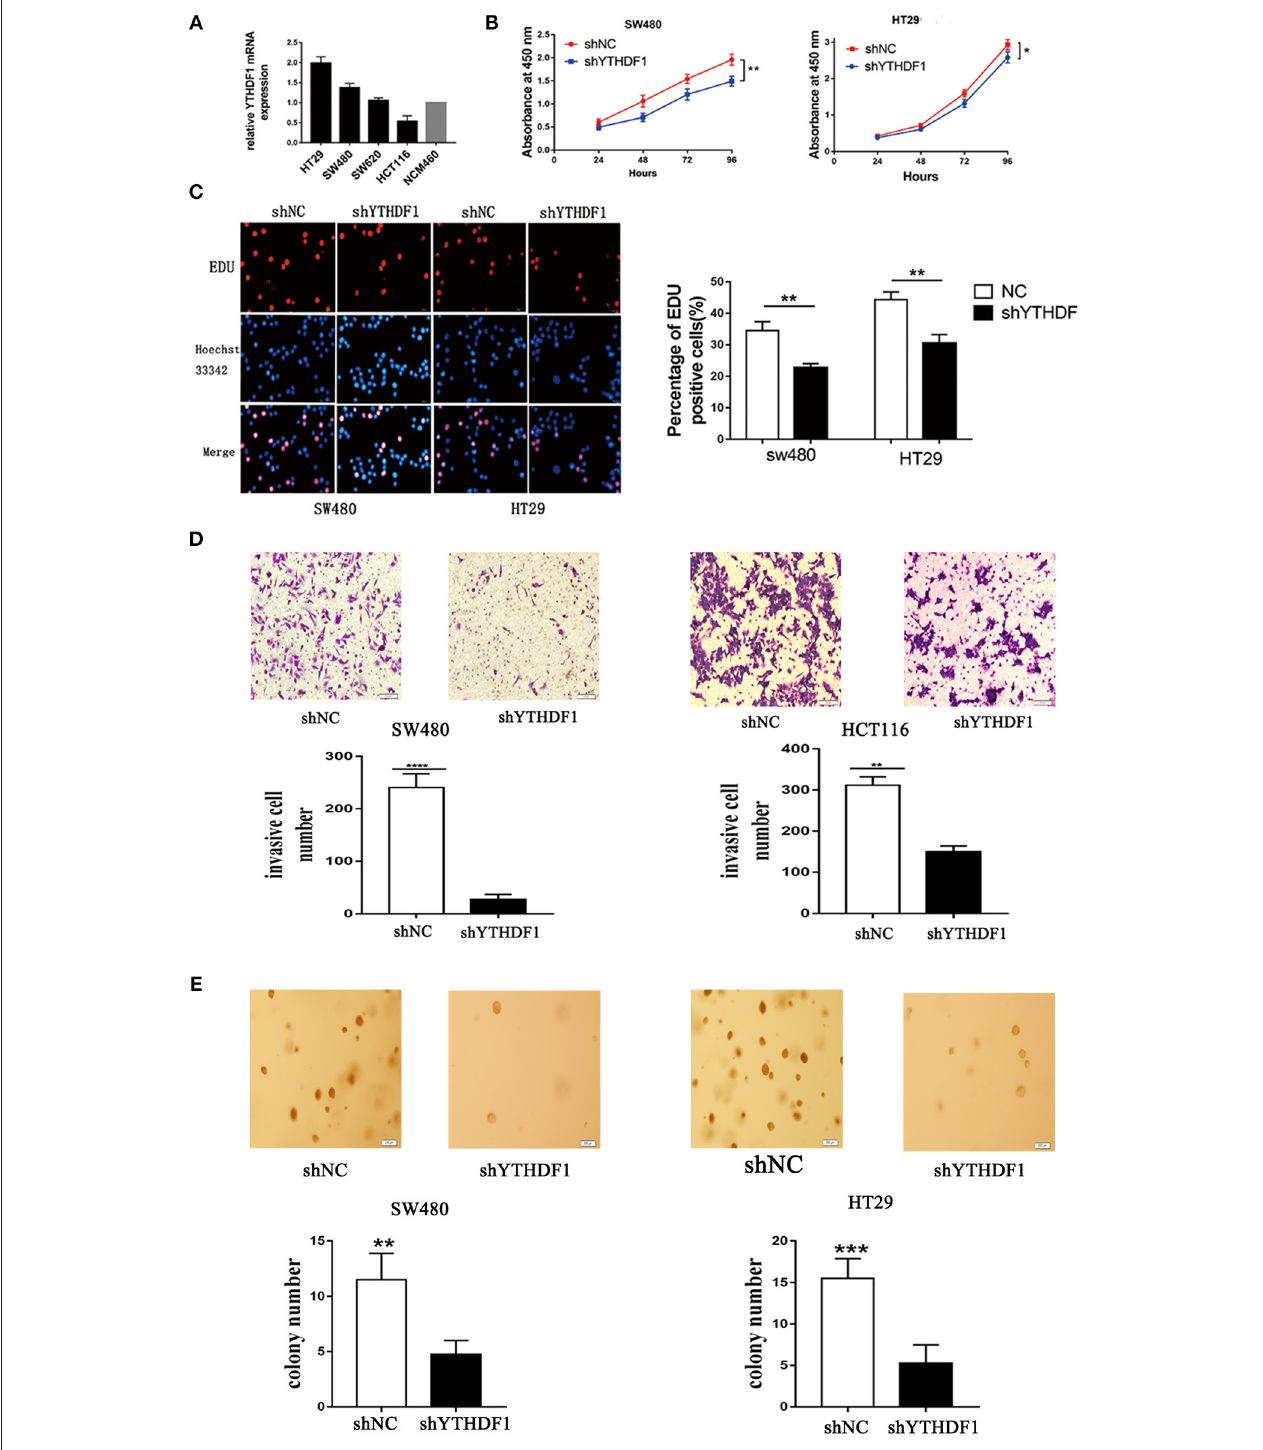
FIGURE 3 | YTHDF1 Regulates CRC Cell Tumorigenicity in vitro . (A) mRNA expression of YTHDF1 in four CRC cell lines (HT29, SW480, SW620, HCT116), and normal human colon epithelial cell line (NCM460). (B) Knockdown of YTHDF1 significantly reduced cell proliferation by CCK8 assay in SW480 and HT29. (C) Representative images of Edu assay (scale bar, 20 um;) (left), and the ratio of EdU positive cells to total Hoechst33342 positive cells (right). (D) Representative images of the Matrigel invasion assay implying that knockdown of YTHDF1 reduce SW480 and HCT116 cell invasion (scale bar, 100 µ m). (E) Representative image of the anchorage-independent growth assays implaying that knockdown of YTHDF1 reduced anchorage-independent growth of SW480 and HT29 cell (scale bar, 200 µ m). (* p < 0.05; ** p < 0.01; *** p < 0.001; **** p < 0.0001).